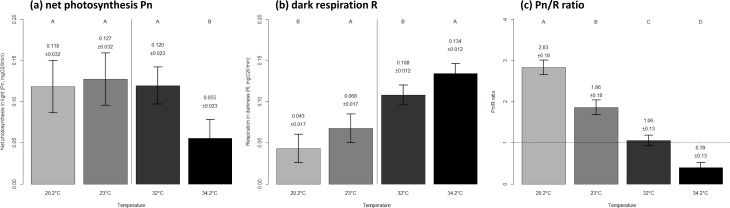
Metabolic performance of corals in constant seasonal temperature levels.Net photosynthesis in light Pn (A), respiration in darkness R (B) and autotrophic capability Pn/R ratio (C) of corals exposed to a range of temperatures as observed on Hengam reefs. The mean ± SE values are indicated on graphs. Letters on top indicate statistically different groups within each season in (A) and (B), and among the four thermal environments in (C). The thermal levels correspond to the winter minimum of 20.2 °C, winter average of 23 °C, summer average of 32 °C, and summer maximum of 34.2 °C.